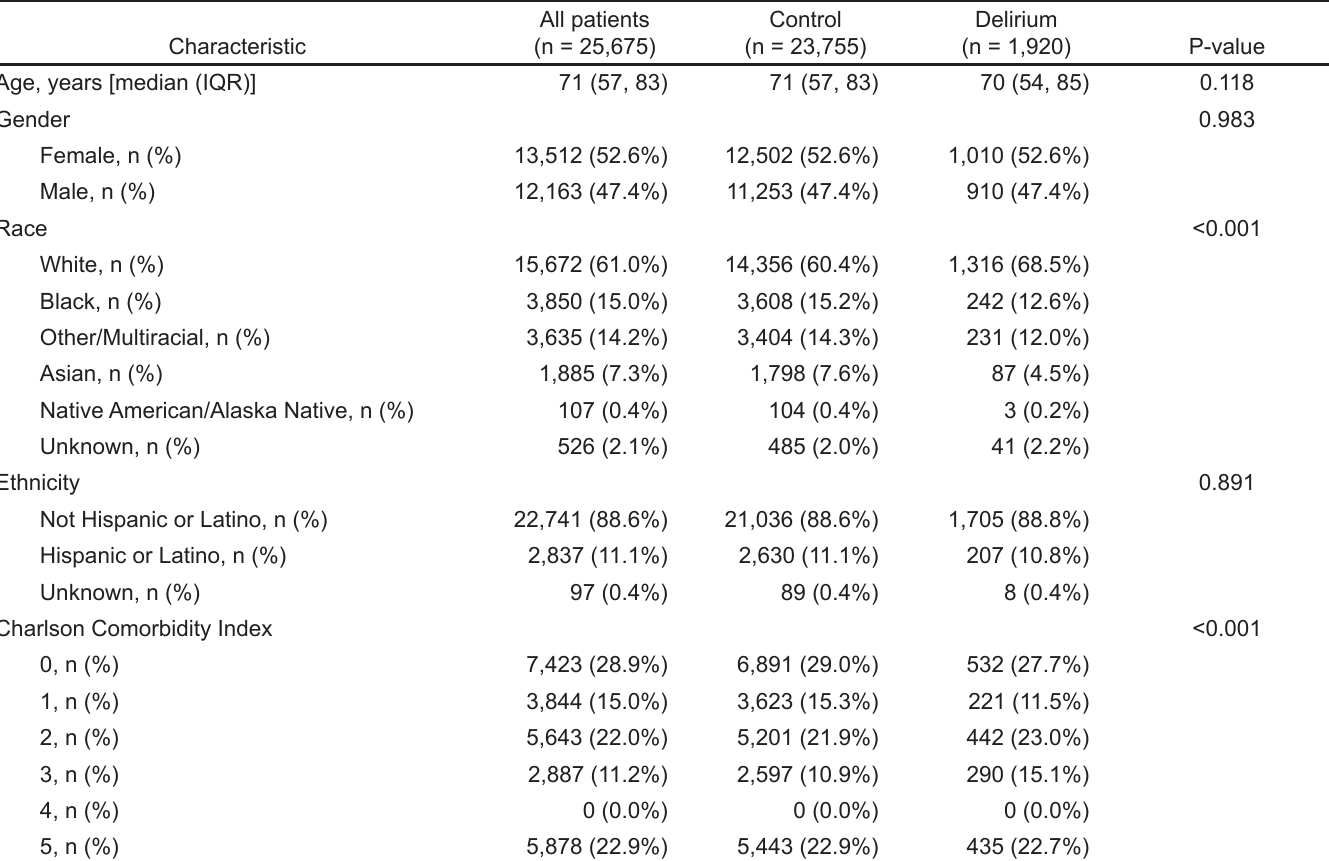
Table 2. Sample characteristics.